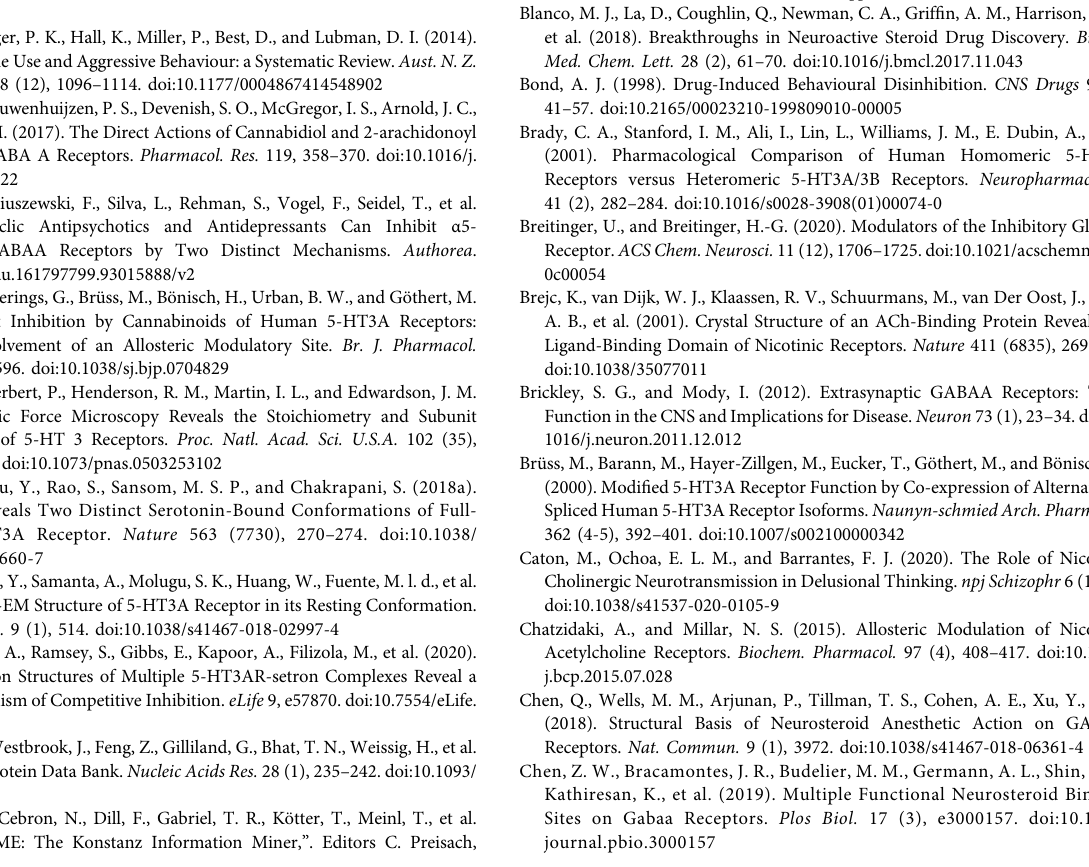
Supplementary Figure S21 | Tentative THC binding sites and candidate positions for mutational analysis. Ribbon rendering of two subunits ’ TMD domains, helices that contribute to sites 3, 4, or 5 are labeled. Colour codes match Figure 9 . Site 3 in the upper TMD: Representative docking pose of THC (green) in superposition with PNU-120596 (light pink, 7EKT). Green ribbon segments on principal TM2, TM3 and on complementary TM1 form ligand contacts. The segment numbering matches the table below the image, amino acid numbering as in (PDBID - 5OSB) for all sites. Site 4: Representative docking pose of THC (cyan) in superposition with THDOC (light pink, 5OSB). Cyan ribbon segments on principal TM3 and